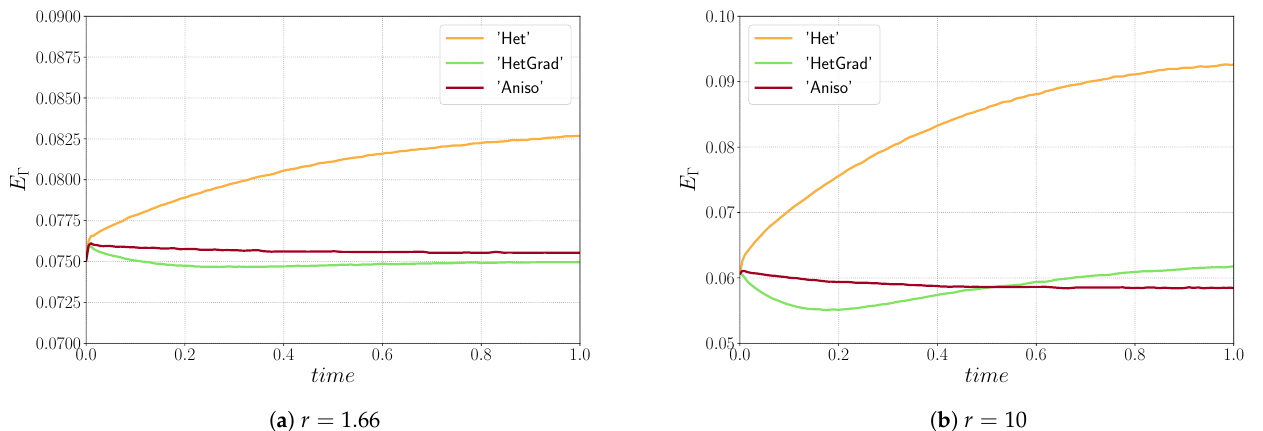
Figure A5. Variation of the interfacial energy, E Γ , using two different values of r